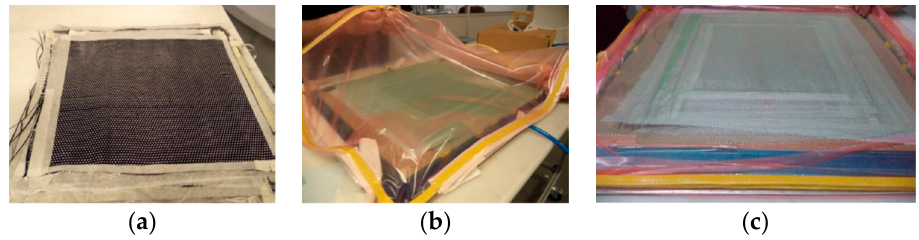
Figure 11. Photographs of technological samples manufacturing ( a ) applied vacuum; ( b ) resin transfer moulding (RTM) system inside the hot-press; ( c ) closed hot press.